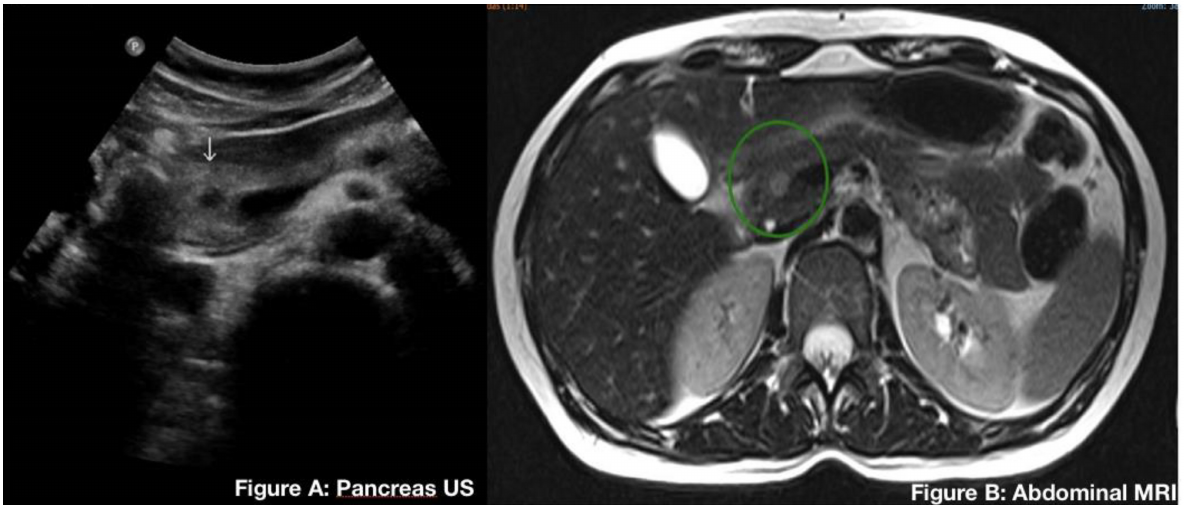
Figure 1. ( A ) (Arrow) Abdominal ultrasound showing a solid nodule of 0.9 cm on the head of the pancreas. ( B ) (Green circle) Abdominal magnetic resonance imaging (MRI) highlighting the same well circumscribed 0.9 cm